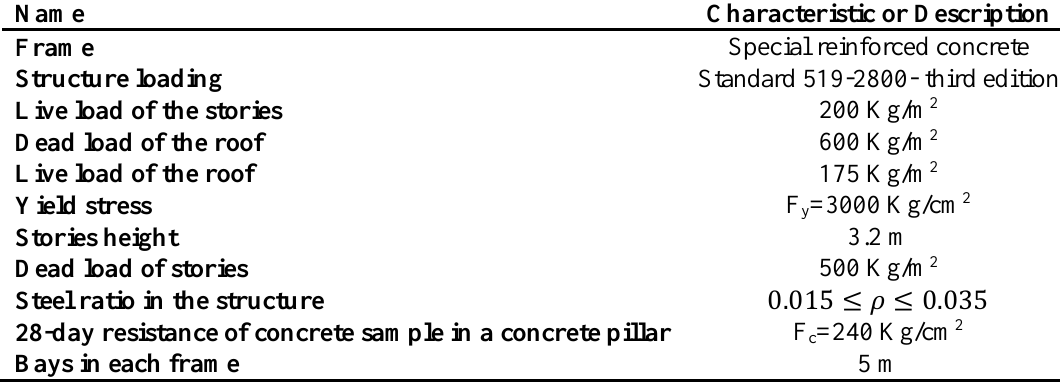
Characteristics of concrete frame with a shear wall containing 4-stories and 4 bays